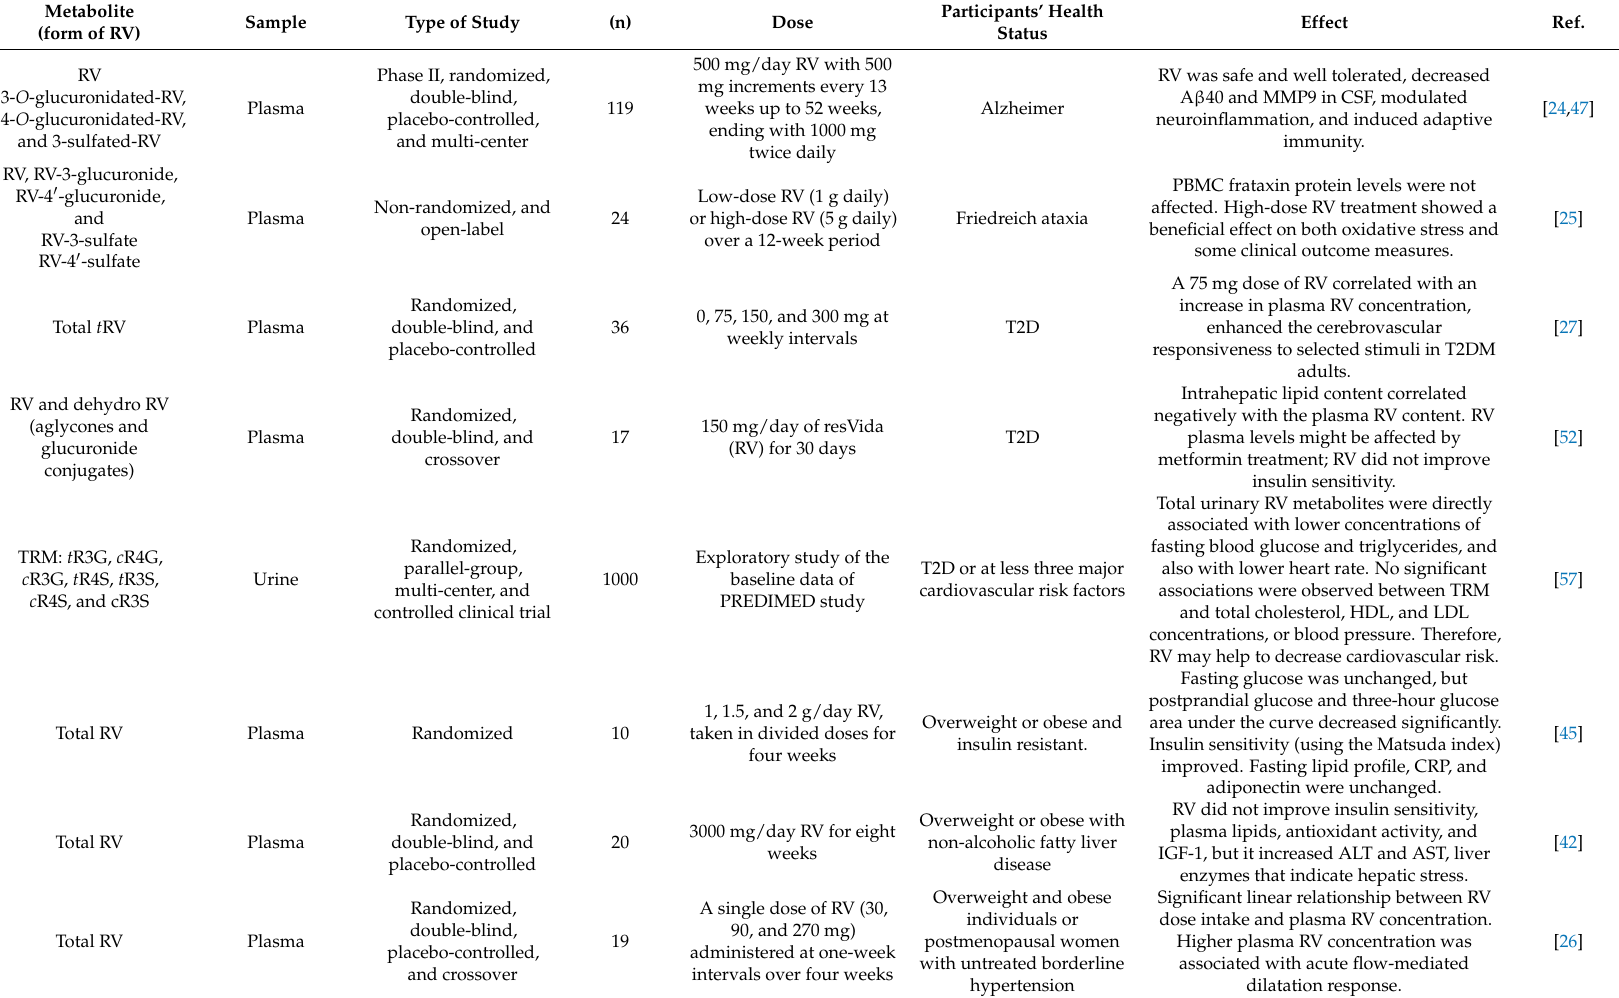
Table 2. Effects of resveratrol on individuals with different health status reported in the last 10 years